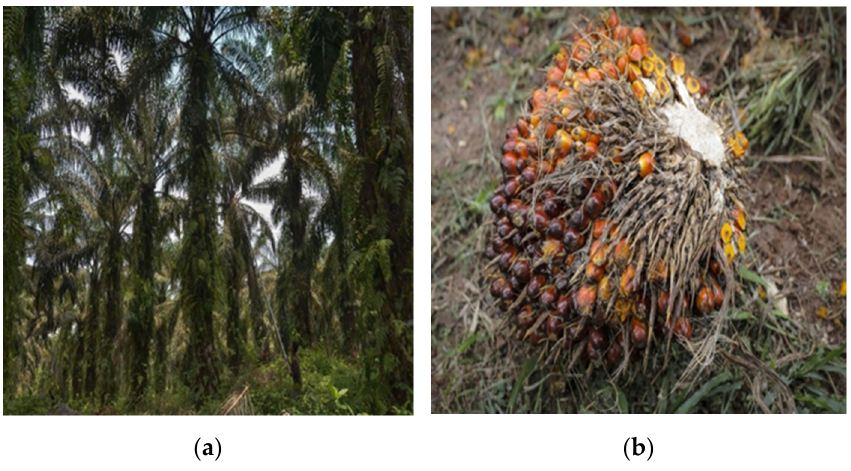
Figure 1. ( a ) An oil palm tree and ( b ) a palm oil seed bunch oil.